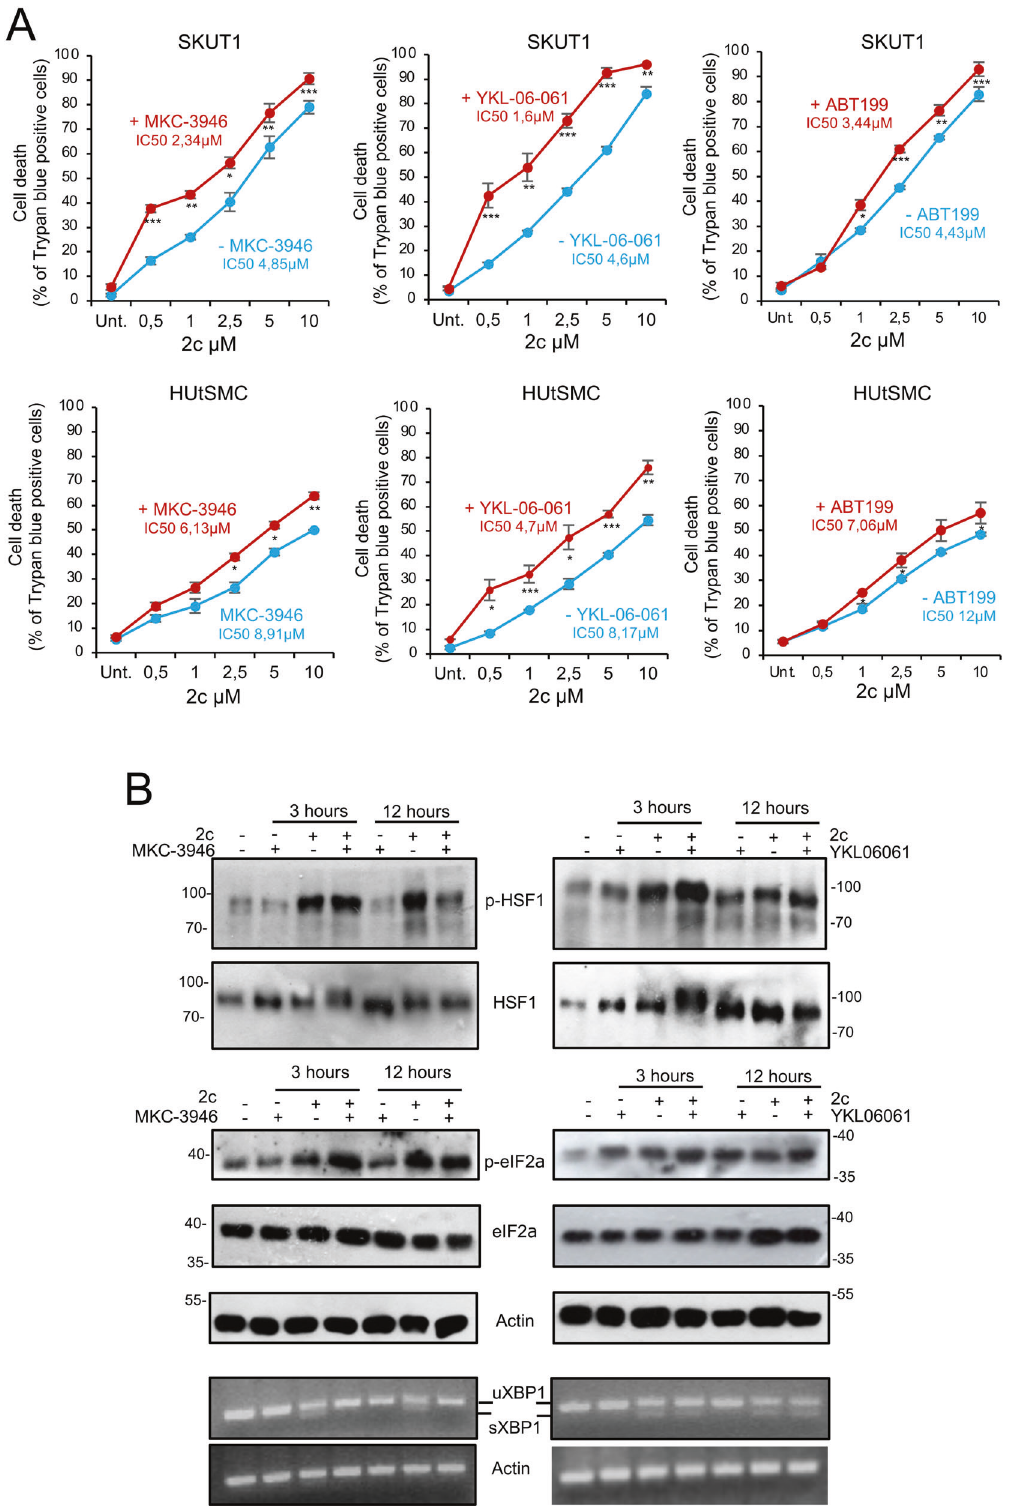
Fig. 6 Effect of PERK and SIKs inhibitors on cell death in response to proteotoxic stress. A Cell death after 24 h of combined treatment with the indicated concentrations of 2c and MKC3946 (10 μ mol/L), YKL-06-061 (1 μ mol/L), and ABT199 (100 nmol/L). B SK-UT-1 cells were treated for 3 or 12 h with 2c (0.5 µmol/L) in the presence or not of MKC3946 (10 μ mol/L) or of YKL-06-061 (1 μ mol/L). Immunoblots were performed using the indicated antibodies. Actin was used as a loading control. RT-PCR products for the full-length XBP1 transcript ( XBP1u ) and the spliced form ( XBP1s ) are also shown.